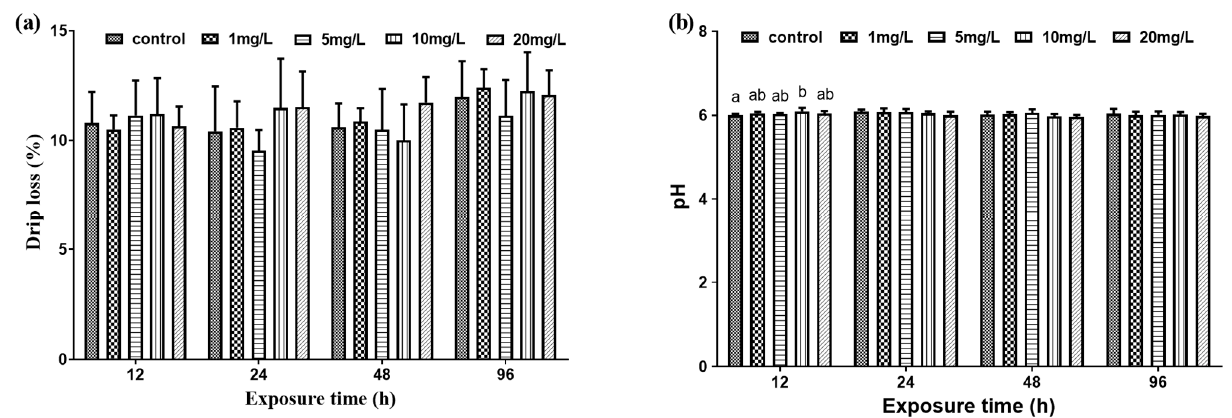
Figure 4. Drip loss (%) and pH in M. amblycephala juveniles exposed to different nitrite concentrations from 12 h to 96 h. Data are expressed as mean ± SD (n = 3). ( a ) Percentage of drip loss; ( b ) PH value. Different letters represent significant differences among treatments ( p < 0.05).